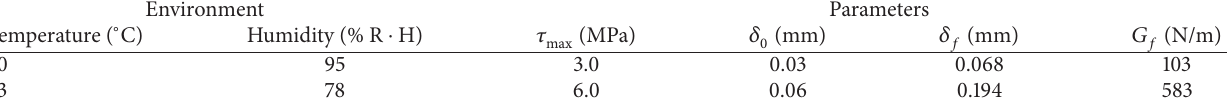
Figure 6: Finite element mesh of CFL-RC beam. Table 1: CZM parameters.